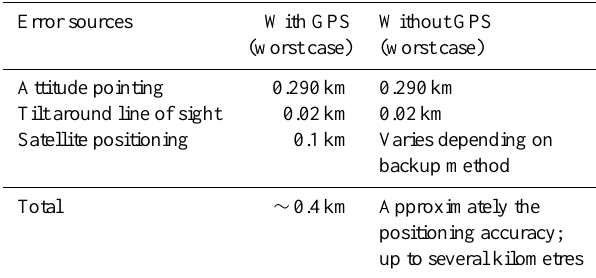
Table 2. The estimates of various error sources on one image edge with and without inclusion of a GPS receiver. These are worst case values, without any post-processing